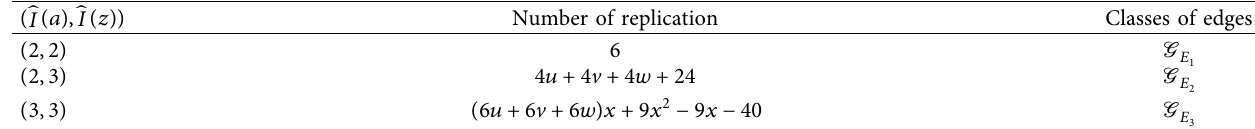
Table 3: Edge partition of C [ u, v,w, x ] established on degrees of terminal vertices of each 2